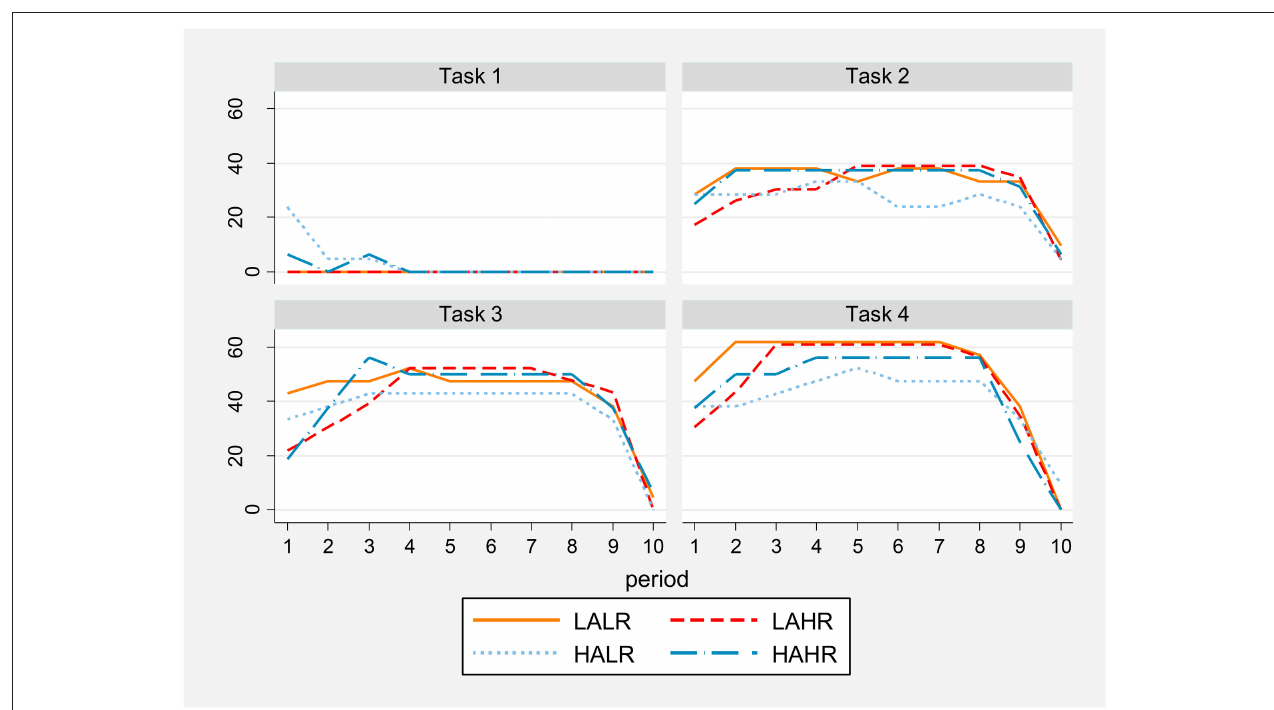
FIGURE 7 | Percentage of paired cooperation by task, period and treatment.